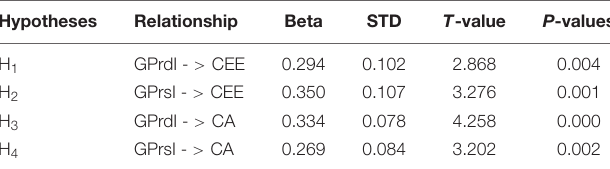
TABLE 4 | Structural model assessment (direct effect results and decision).